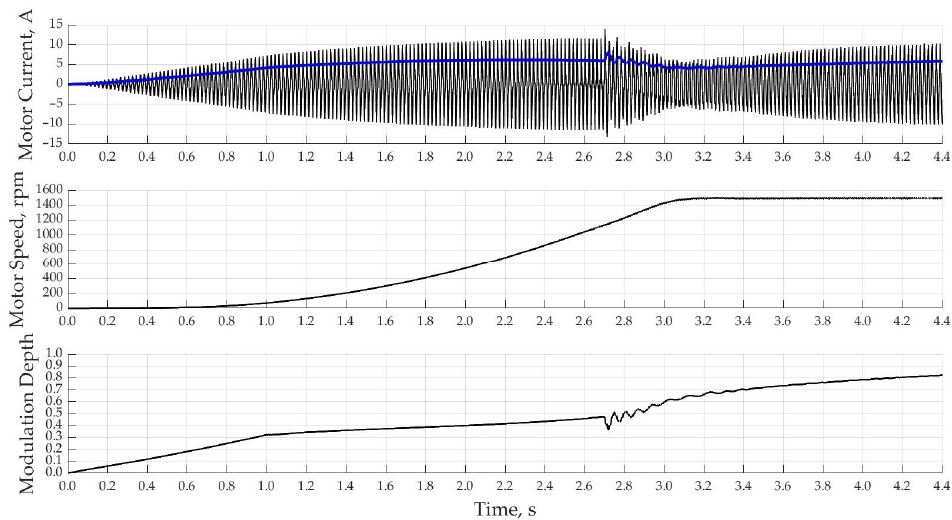
Figure 14. Starting current, motor speed and modulation depth with PI-controller with single-loop CS of IM current with linear increase in current by reference.